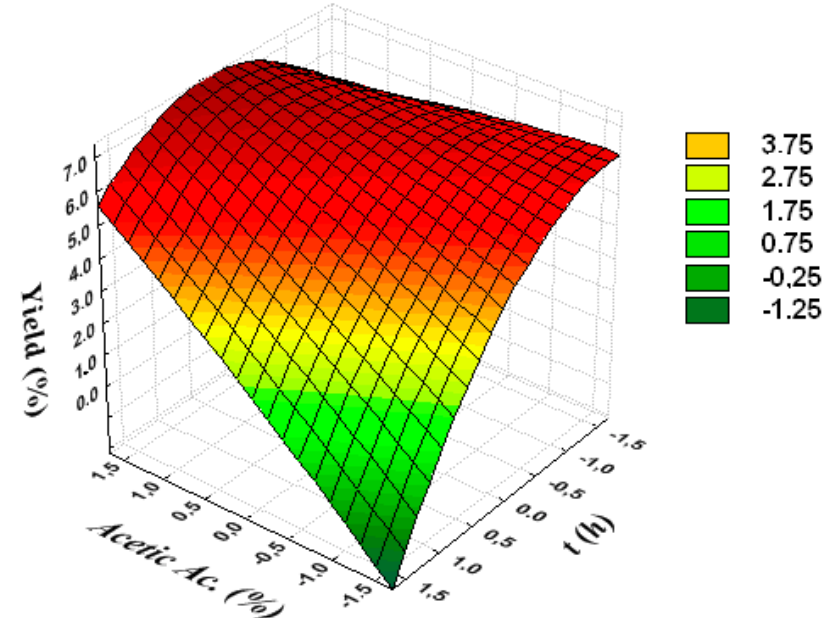
Figure 1. Response surface to show the mutual influence of acetic acid concentration and processing time on extraction yield.